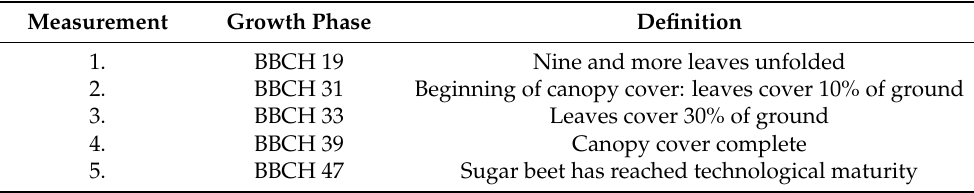
Table 5. Growth phases of leaf area index